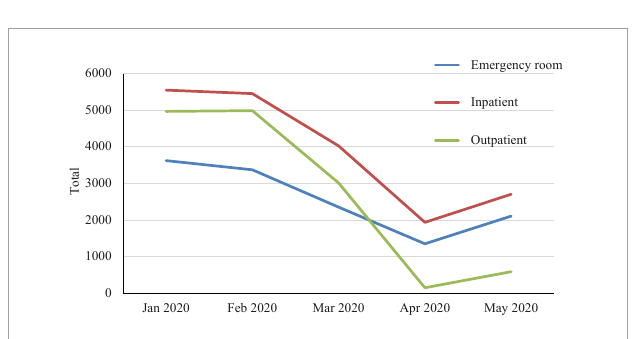
FIGURE2 The change in imaging case volumes over time in January–May 2020 stratified by patient service location.